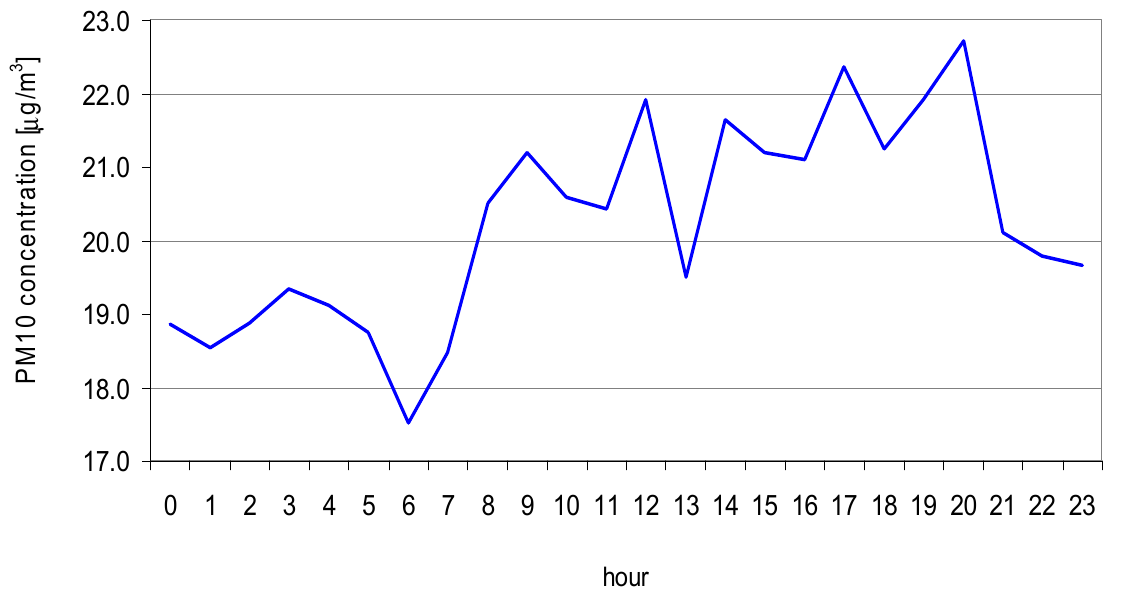
Figure 2. The average hourly PM 10 concentrations averaged for the entire measurement period (03–31.07.2019), as measured by the receptor.